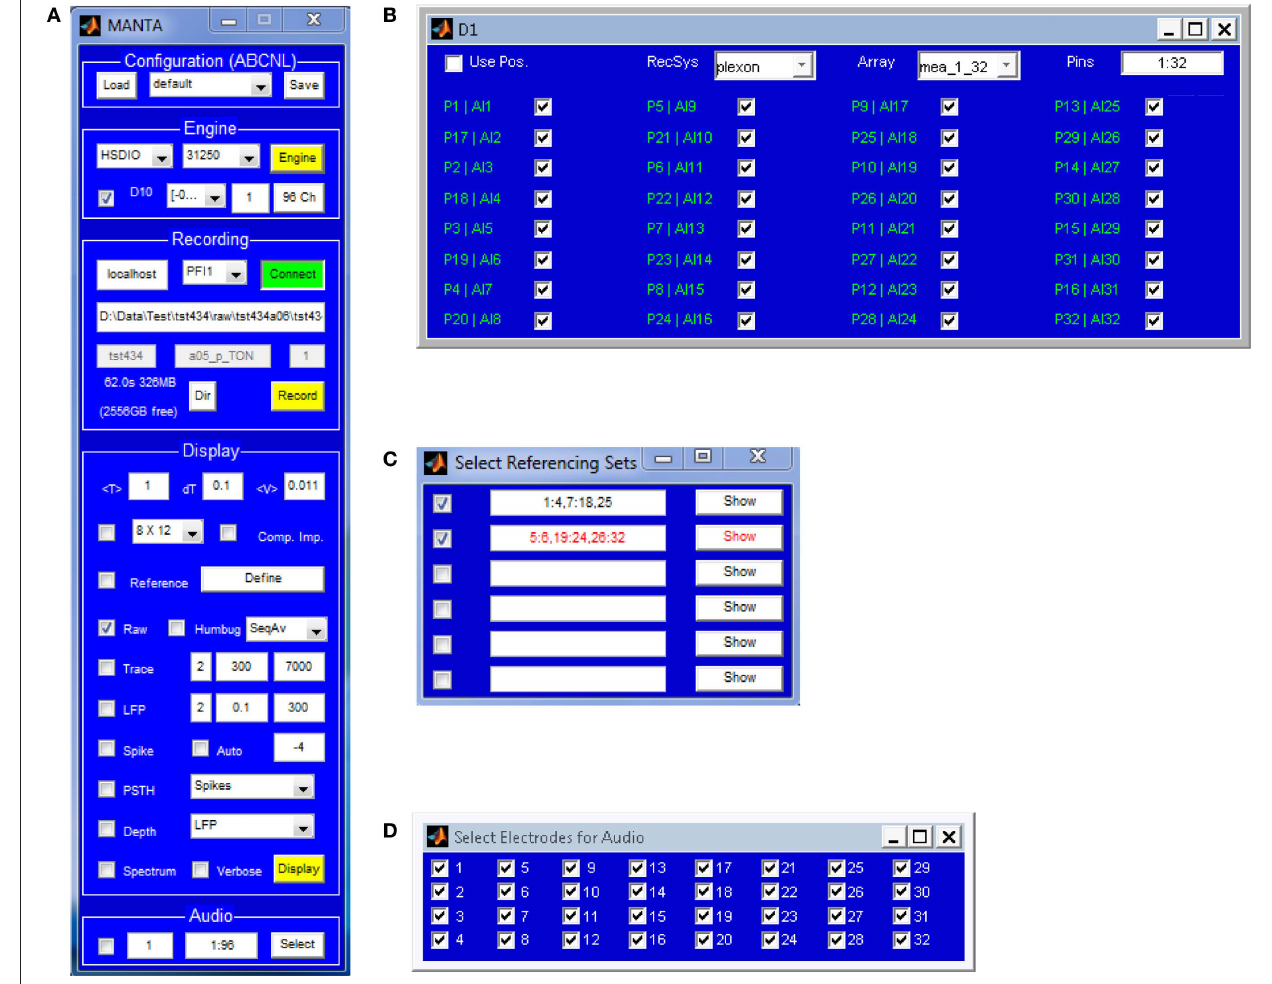
FIGURE 2 | The main window (A) of MANTA consists of 5 panels (lighter blue areas): configuration, Engine, Recording Display and Audio. In the Configuration panel, system configurations can be saved for later use and loaded again. Essentially all settings in MANTA can be controlled from the GUI. The Engine panel controls which data acquisition hardware is used, selects channels (B) , sets parameters of the acquisition such as sampling rate or input range, selects electrode array layout, and starts and stops acquisition. The Recording panel serves a dual purpose: to allow manual recordings and display information about the current